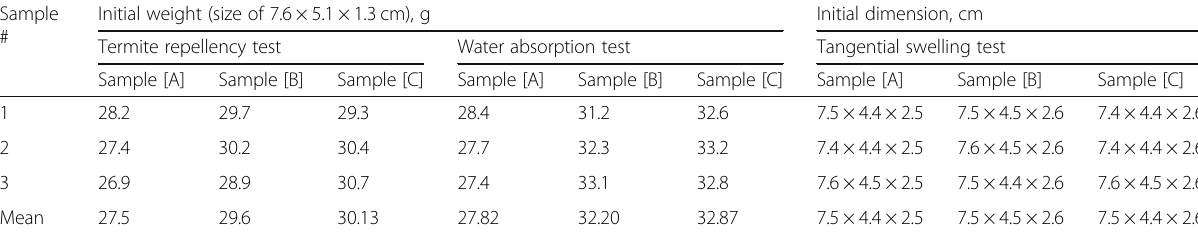
Table 4 Initial physical characteristics of coco wood samples, n = 27 Sample #